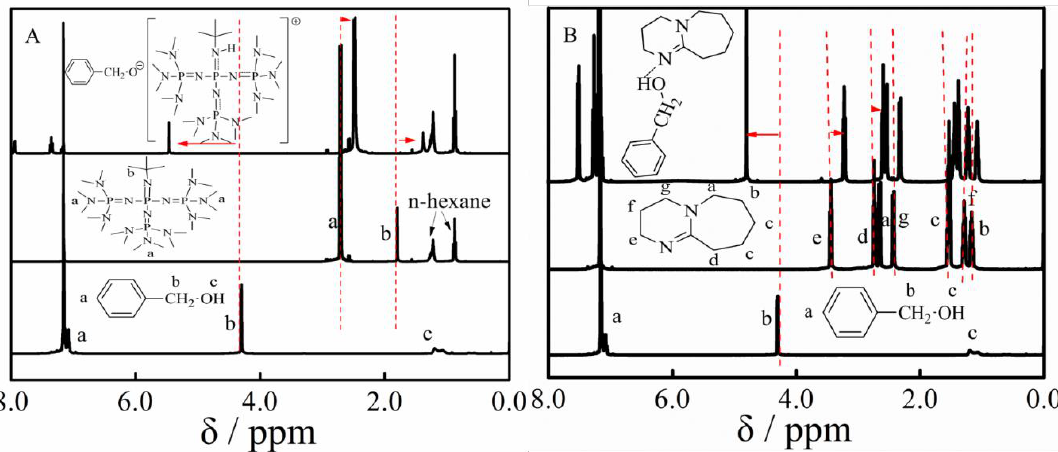
Figure 6. 1 H NMR spectra of ( A ) BnOH, t -BuP 4 and their 1:1 complex in C 6 D 6 , ( B ) BnOH, DBU and their 1:1 complex in C 6 D 6